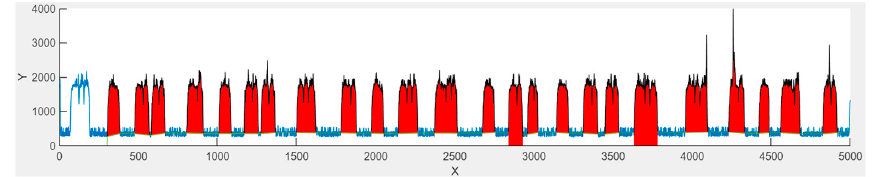
Figure 10. Section of the evaluated oil peaks at the 40% filling degree. The individual peaks have different distances, which illustrates the non-uniform flow. Many peaks have black vertical lines in their upper half. The line indicates the boundary between two drops in a drop chain.